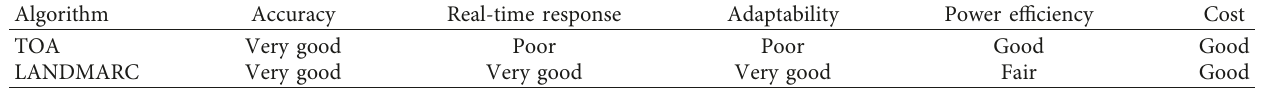
Table 1: Comparison of evaluation indicators for indoor positioning algorithms.